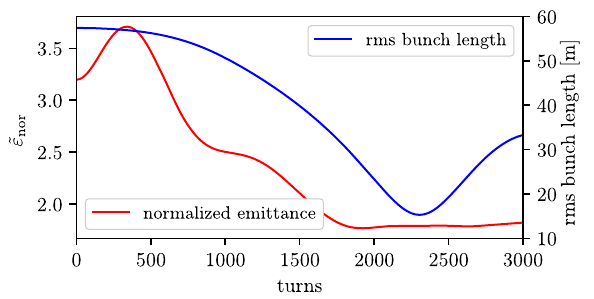
FIG. 15. Variation of rms beam length and normalized emit- tance during bunch merging in